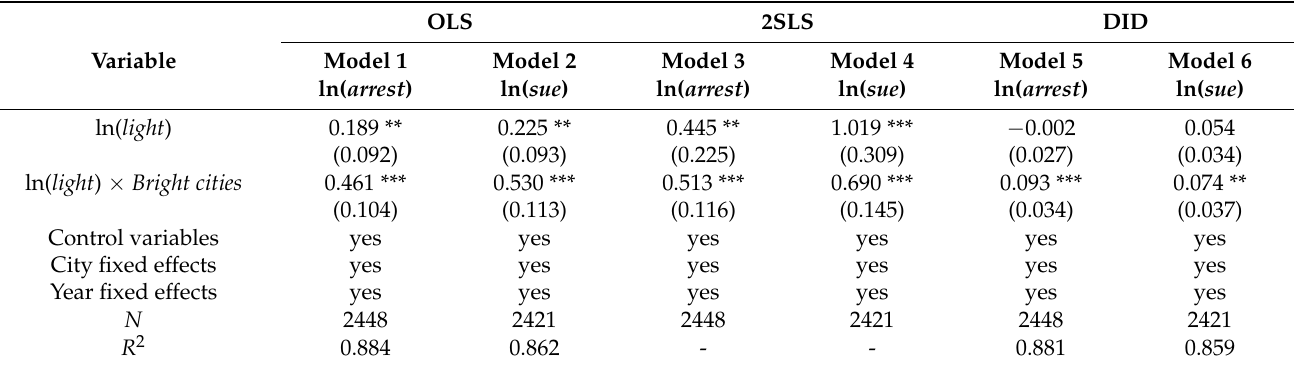
Table 4. Regression results based on light brightness.